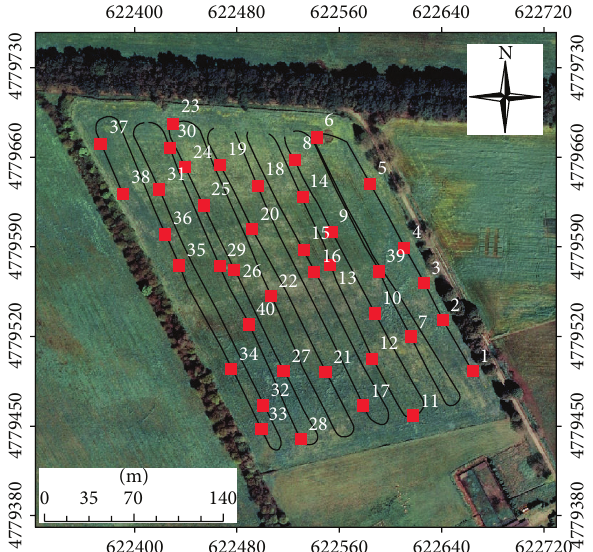
Figure 1: Continuous record of soil apparent electrical conductivity ) obtained by electromagnetic induction (line) and the opti- (EC a mized sampling scheme consisting 40 points